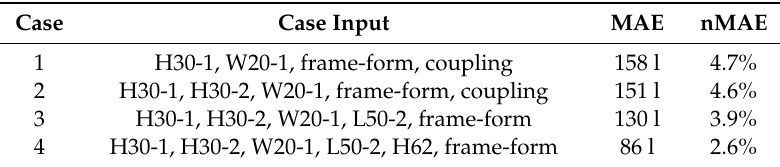
Table 6. Overview of the evaluated scenario and the corresponding